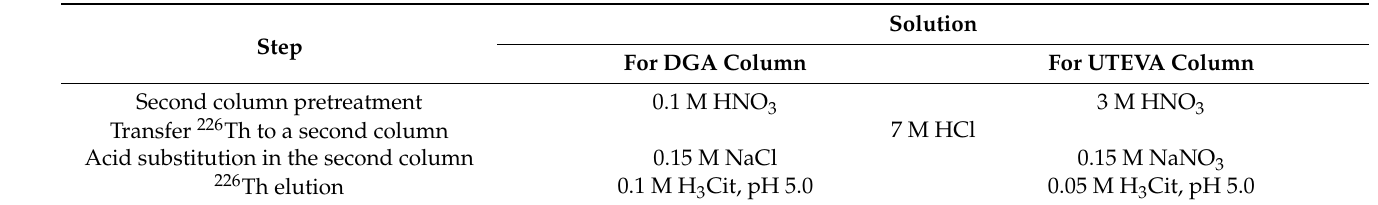
Table 2. Effective procedures of 226 Th extraction from the two-column 230 U/ 226 Th generator (>90% of 226 Th in 1.5 mL of eluate, pH